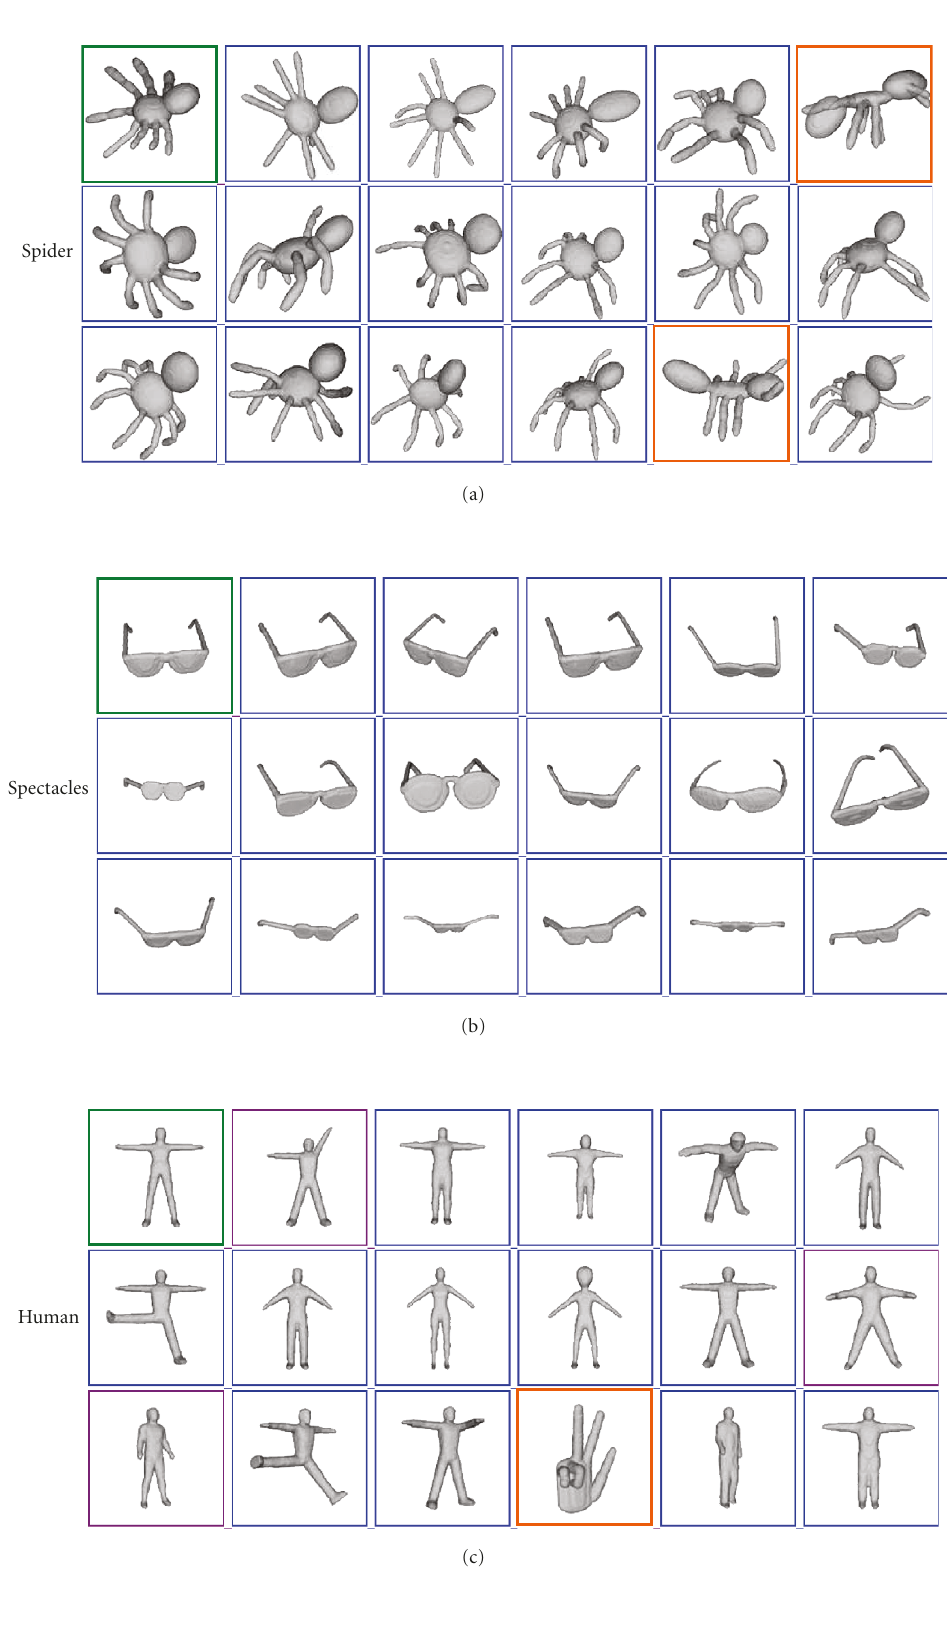
Figure 8: Some retrieval results from the McGill database [19]: green bold frame defines the query shape, and orange bold frame defines the false pick up. Three groups show three di ff erent shapes, in which from top to bottom they are spider, spectacles, and